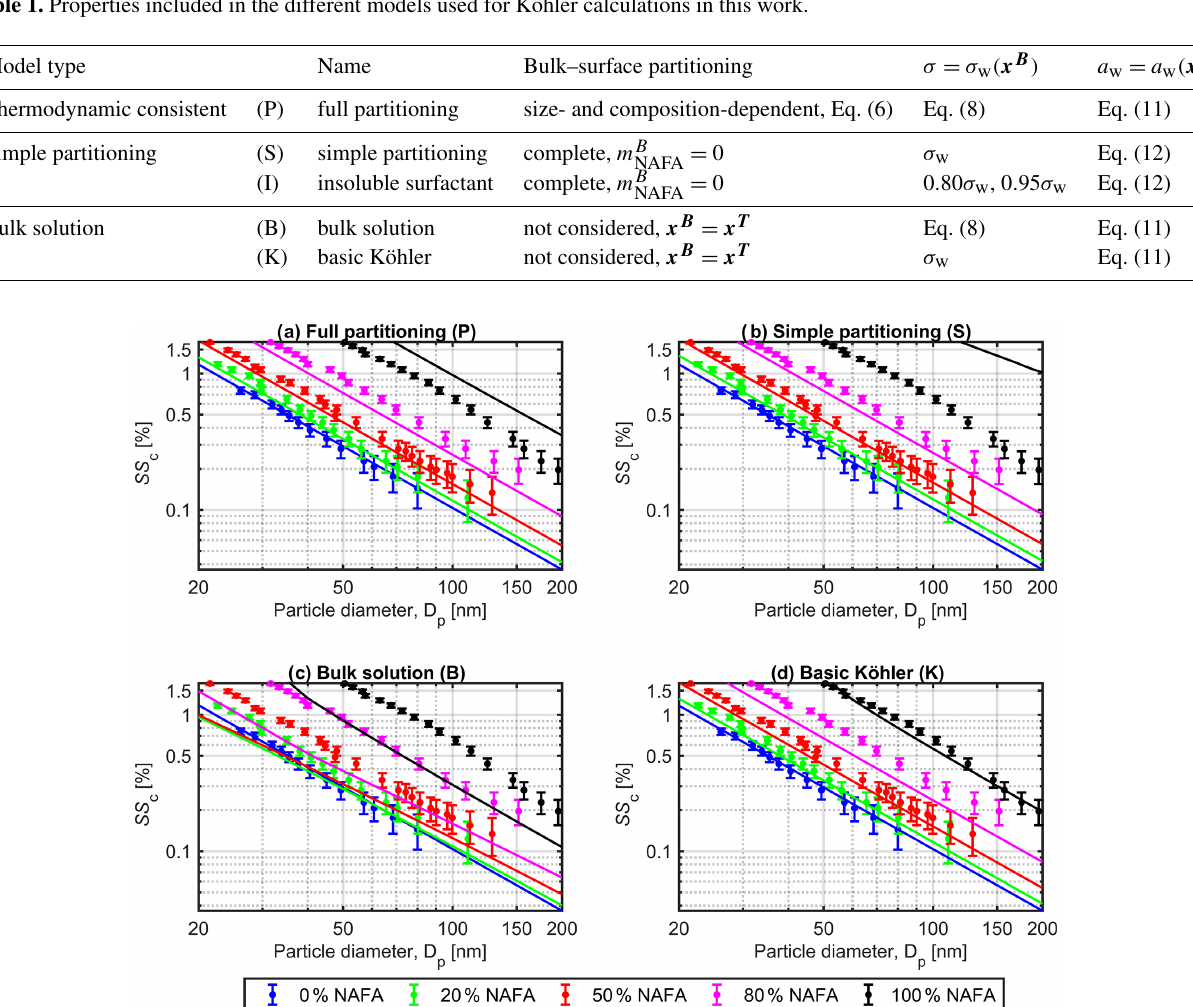
Figure 1. Critical supersaturations (SS c ) for mixed NAFA–NaCl particles, calculated (curves) using the different models described in Sect. 2.4: (a) full partitioning model (P), (b) simple partitioning model (S), (c) bulk solution model (B), and (d) basic Köhler model (K), in each case compared to experimental values (dots) measured by Kristensen et al. (2014). Colors indicate the original dry-particle fraction of NAFA ( W p , NAFA ) relative to NaCl. Calculations are made using a NAFA mass density of ρ NAFA = 1 . 6gcm − 3 . Error bars on experimental data represent ± 1 standard deviations on SS c as reported by Kristensen et al.